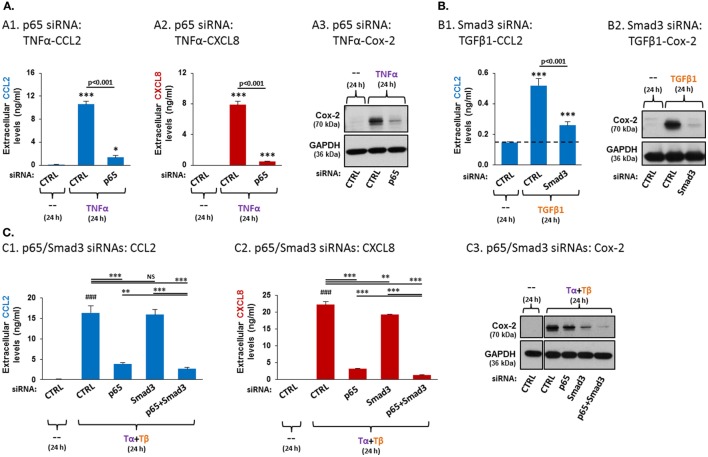
Following TNFα + TGFβ1 stimulation of MSCs, p65 is the major regulator of CCL2 and CXCL8 expression, while Smad3 is the predominant regulator of Cox-2 expression, cooperating with NF-κB activation. Human BM-derived MSCs were transiently transfected with control siRNA, with siRNA to p65 or with siRNA to Smad3 and were stimulated as described below. siRNA concentrations were selected based on preliminary titration analysis (data not shown). The expression of CCL2, CXCL8 and Cox-2 was determined as described in Figure 5. (A) p65 siRNA effects on TNFα-mediated induction of CCL2 (A1), CXCL8 (A2) and Cox-2 (A3). Following transfection with control siRNA (“CTRL”, 30 nM) or siRNA to p65 (30 nM; efficacy of p65 downregulation is demonstrated in Figure S4A in Supplementary Material), the cells were stimulated with vehicle (“--”) or TNFα (50 ng/ml) for 24 h (0.5% FBS-containing medium). Comment: findings on p65 siRNA effects on TNFα-induced CCL2 and CXCL8 were demonstrated in our published report (41), but in different conditions than in the current study. ***p ≤ 0.001, *p < 0.05 compared to vehicle-treated, control siRNA-transfected cells. (B) Smad3 siRNA effects on TGFβ1-mediated induction of CCL2 (B1) and Cox-2 (B2). Following transfection with control siRNA (“CTRL”, 30 nM) or siRNA to Smad3 (30 nM; efficacy of Smad3 down-regulation is demonstrated in Figure S4B in Supplementary Material), the cells were stimulated with vehicle (“--”) or TGFβ1 (10 ng/ml) for 24 h (0.5% FBS-containing medium). ***p ≤ 0.001 compared to vehicle-treated, control siRNA-transfected cells. (C) The effects of p65 siRNA and Smad3 siRNA on TNFα + TGFβ1-mediated induction of CCL2 (C1), CXCL8 (C2) and Cox-2 (C3). MSCs were transfected with control siRNA (“CTRL”, 60 nM) or with siRNAs to p65 (30 nM p65 siRNA + 30 nM control siRNA), Smad3 (30 nM Smad3 siRNA + 30 nM control siRNA) or siRNAs to both p65 + Smad3 (30 nM each; efficacies of p65 and Smad3 downregulations are demonstrated in Figures S4C1,C2 in Supplementary Material). Then, the cells were stimulated with vehicle (“--”) or TNFα (50 ng/ml) + TGFβ1 (10 ng/ml) for 24 h (0.5% FBS-containing medium). Tα + Tβ = TNFα + TGFβ1. ***p ≤ 0.001, **p ≤ 0.01. NS, not significant. ###p ≤ 0.001 compared to vehicle-treated, control siRNA-transfected cells. In all panels, the findings are representatives of n = 3 independent experiments, performed with MSCs of two different donors, which have shown similar results. In panel C and in Figures S4C1,C2 in Supplementary Material, all the results were obtained in parallel with MSCs of one donor; similar findings, obtained in MSCs from another donor, are demonstrated in Figure S5 in Supplementary Material.